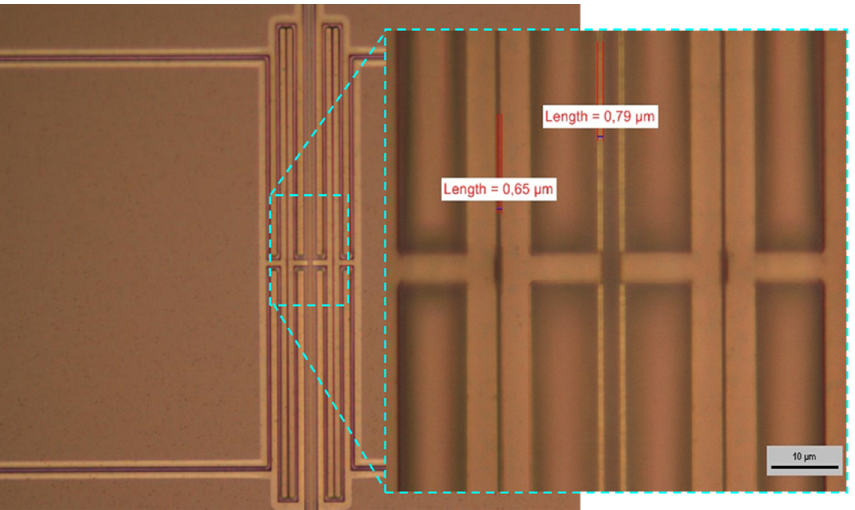
Figure 7. Submicrometric features on released DETF structures fabricated in 3C-SiC grown on <100> silicon.